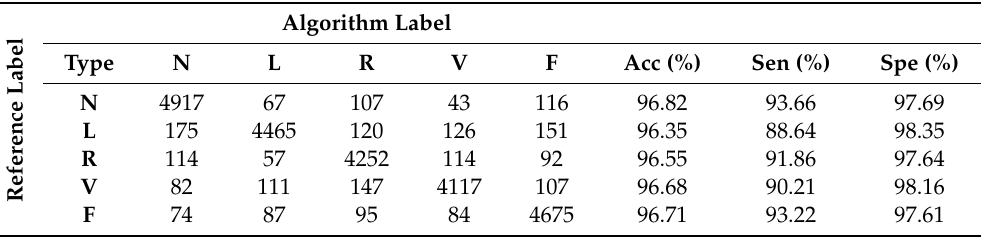
Table 11. The classification results of the OVR